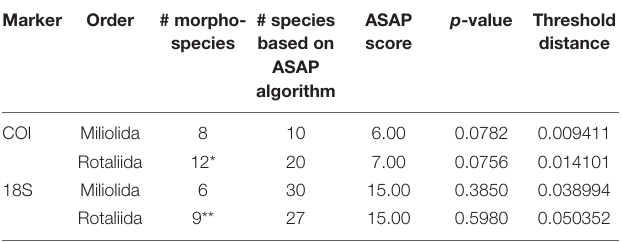
TABLE 4 | ASAP results performed separately on the orders Rotaliida and Miliolida representing best the dataset. Marker Order